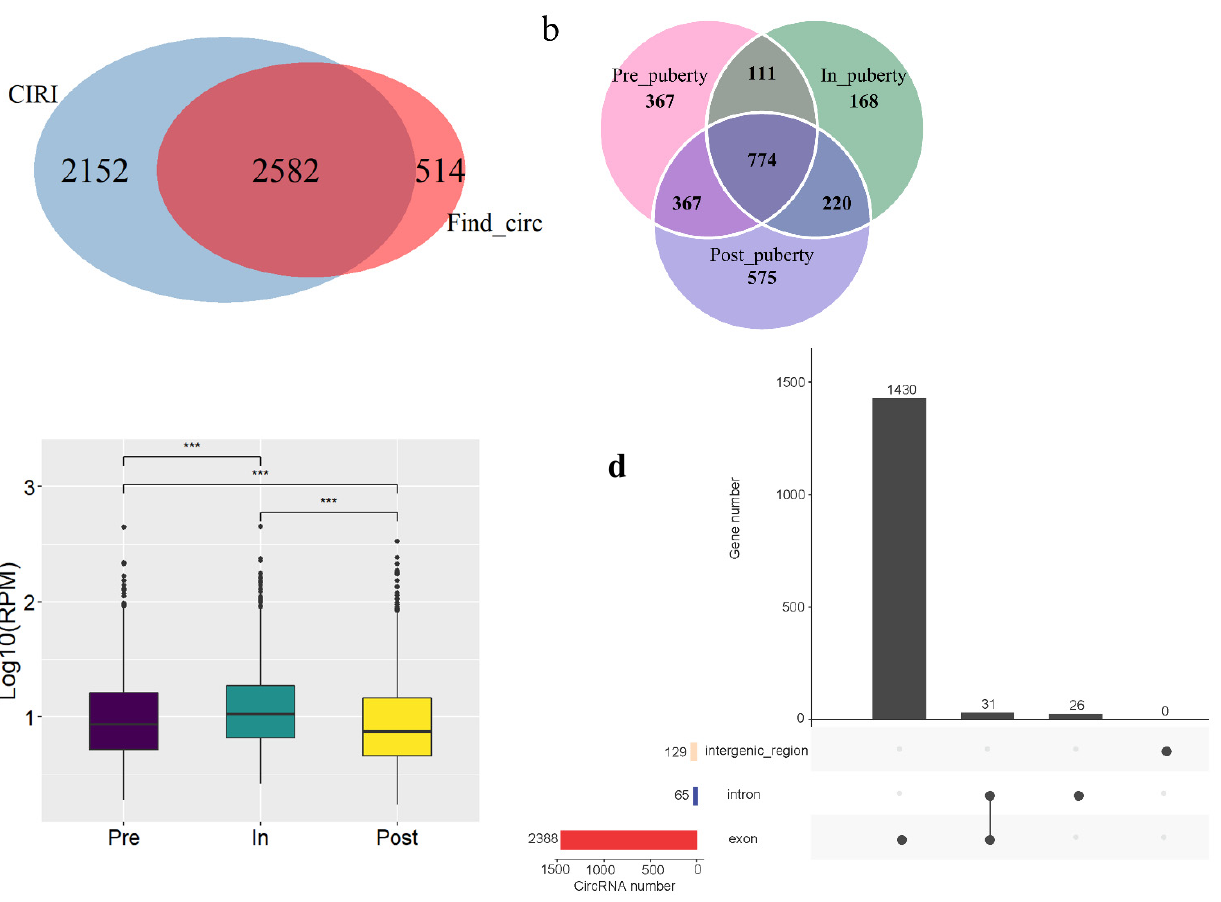
Figure 1. Overview of the identified circRNAs by RNA-seq analyses in ovaries of gilts. ( a ) The circRNAs were identified by two algorithms (CIRI and find_circ). ( b ) The number of unique and common circRNAs during pre-, in- and post-puberty. ( c ) Expression level of circRNAs in the pre-, in- and post-puberty stages. ( d ) The number of three types of circRNA and the number of corresponding parental genes. *** p <